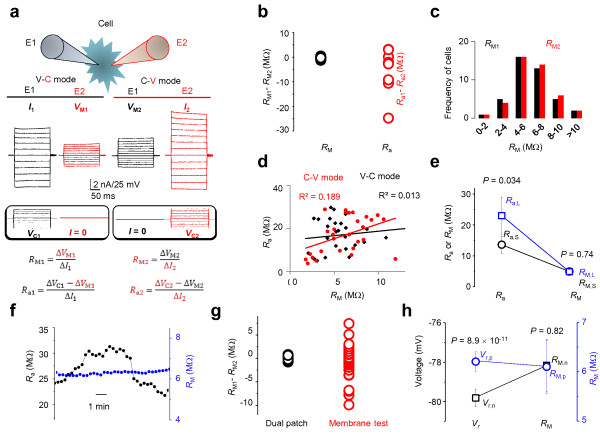
Accurate RM measurement in dual patch recording. (a) Voltage (V) and current (C) modes were alternated between E1 and E2 to obtain two sets of RM and Ra values for comparison. (b) Open black and red circles are RM1-RM2 and Ra1-Ra2 values, respectively (n = 44). Despite a large variation in Ra1-Ra2, the RM1-RM2 varies minimally in the same cells. (c) The RM1 (black, from E1) and RM2 (red, from E2) values were sorted into 2 MΩ intervals and plotted against their respective occurrence frequencies; the frequency distribution patterns are nearly identical for the data obtained from E1 and E2 (n = 54). (d) The pooled Ra and RM values are not correlated. (e) Variation of Ra between the two electrodes does not affect the accuracy of RM measurement. (f) The long-term RM recording remains stable and is independent of variation in Ra. (g)RM1-RM2 varies minimally in dual patch recording compared to measurements obtained from the “membrane test” (pClamp 9.0 software). (h) Within the acceptable range of resting potentials (Vr), VM does not affect the accuracy of RM measurement.